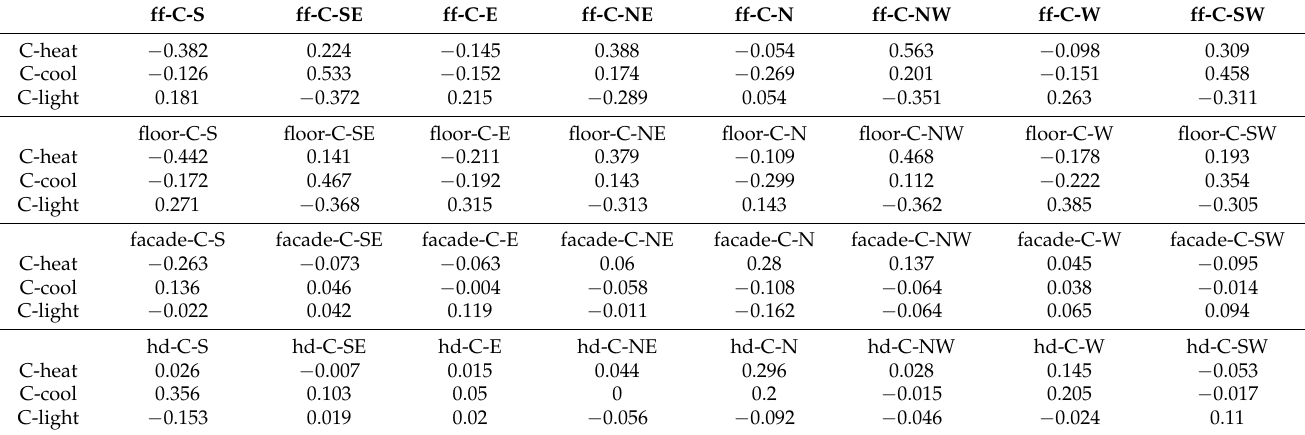
Table 9. Correlation coefficients between energy demands of canteen and its design